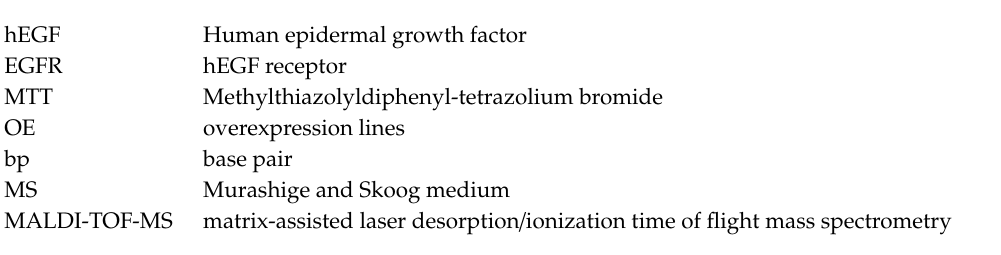
s1. Figure S1. Identification of hEGF protein via MALDI-TOF-MS. Figure S2. The contents of resveratrol in di ff erent hEGF transgenic hairy